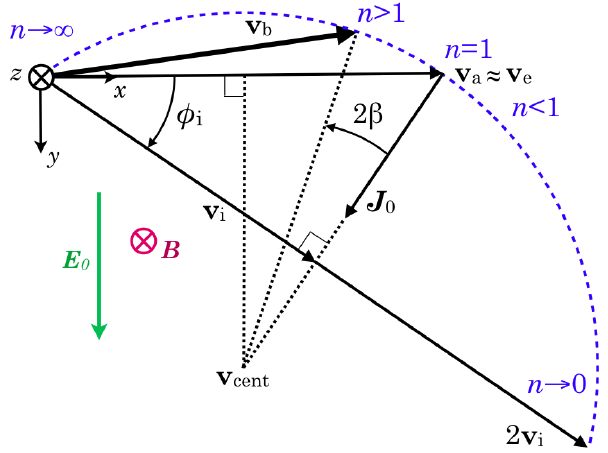
Figure 7. The variation with ion magnetisation κ i of the arc along which the drift of a circular patch can lie. All of the arcs coincide at the origin (the limit of high n ) and at the ambipolar drift (for the case of n = 1). An enhancement always drifts slower than ambipo- lar, with a component against E , whereas a depletion always has a component parallel to E